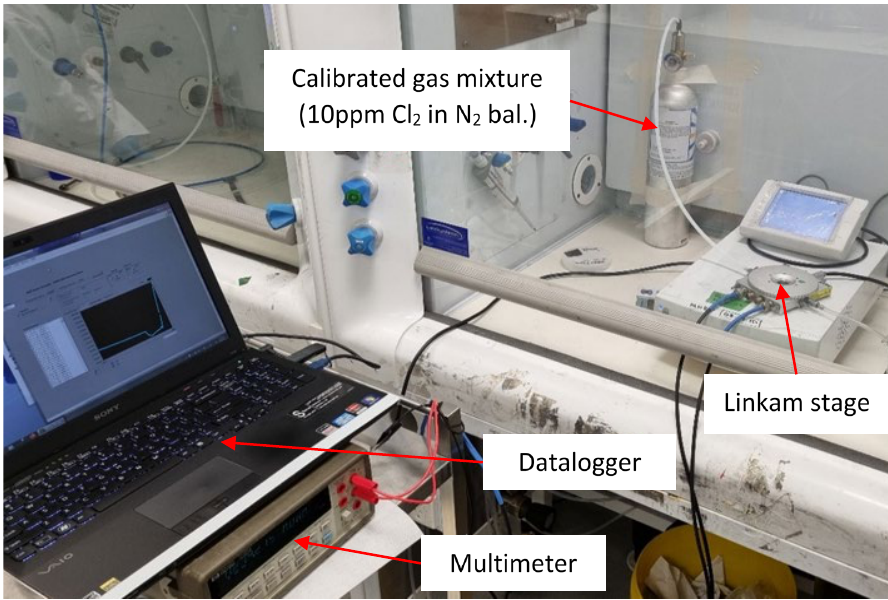
Figure 9. Test setup for the evaluation of Cl 2 gas–sensitive materials.